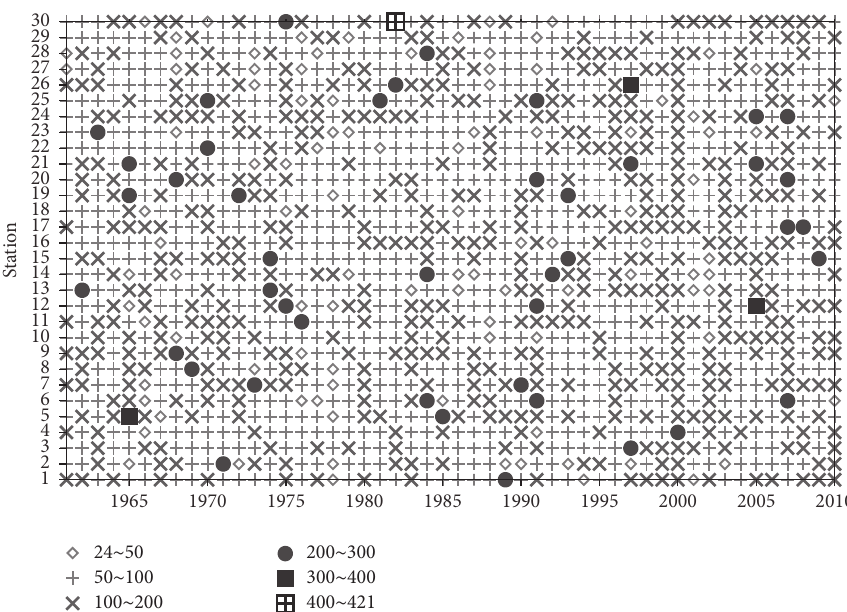
Figure 12: Temporal changes of maximum daily precipitation for each station in HRB. Stations numbers 1 to 30 stand for the